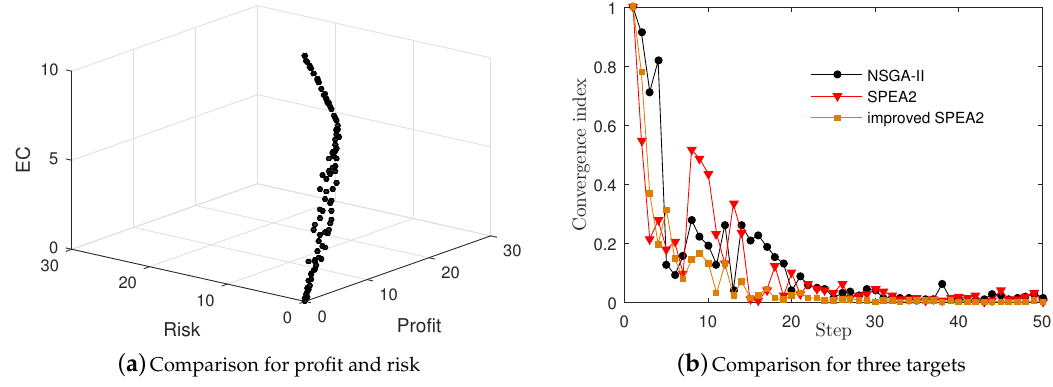
Figure 5. Comparison of convergence results of different